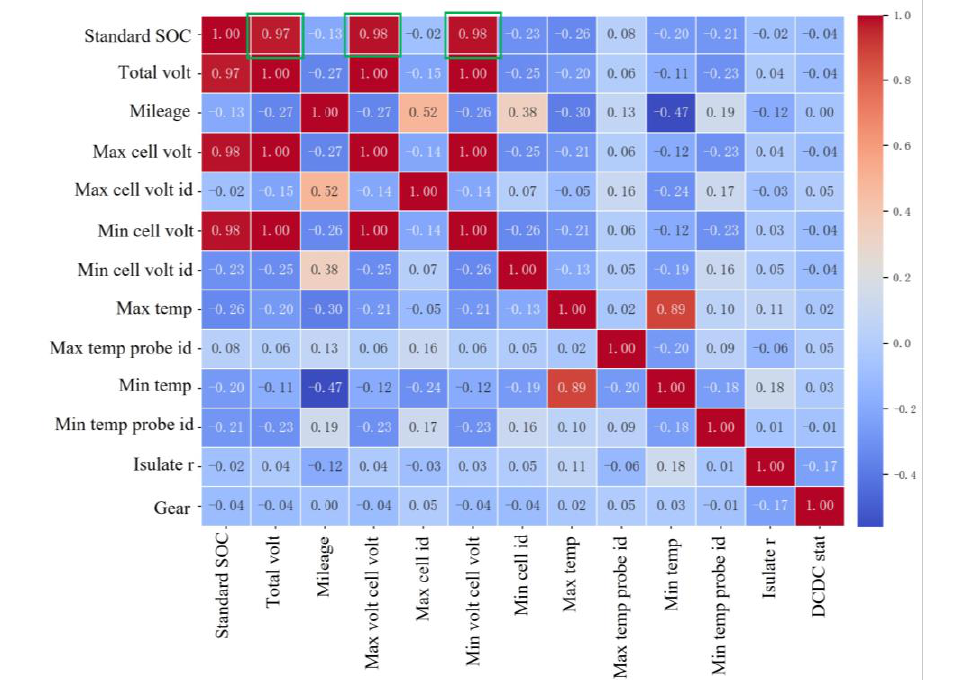
Energies 2023 , 16 , x FOR PEER REVIEW Figure 7. Charge completion correlation coefficient heat map analysis. Figure 7. Charge completion correlation coefficient heat map analysis.